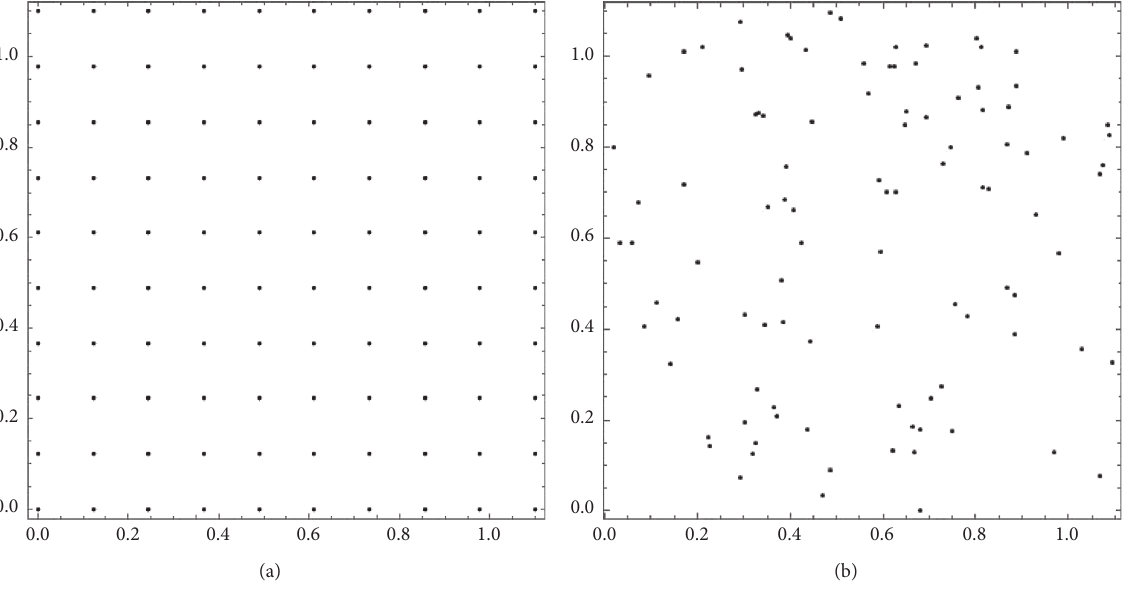
Figure 9: (a) The mesh points. (b) The meshless points. There are 100 points for interpolation.